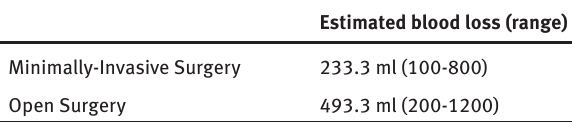
Table 2: Perioperative outcomes